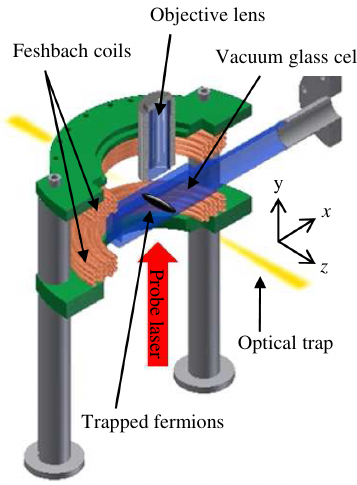
FIG. 1. Schematic diagram of the experimental apparatus. The ˆ z axis is defined as the axial direction of the optical